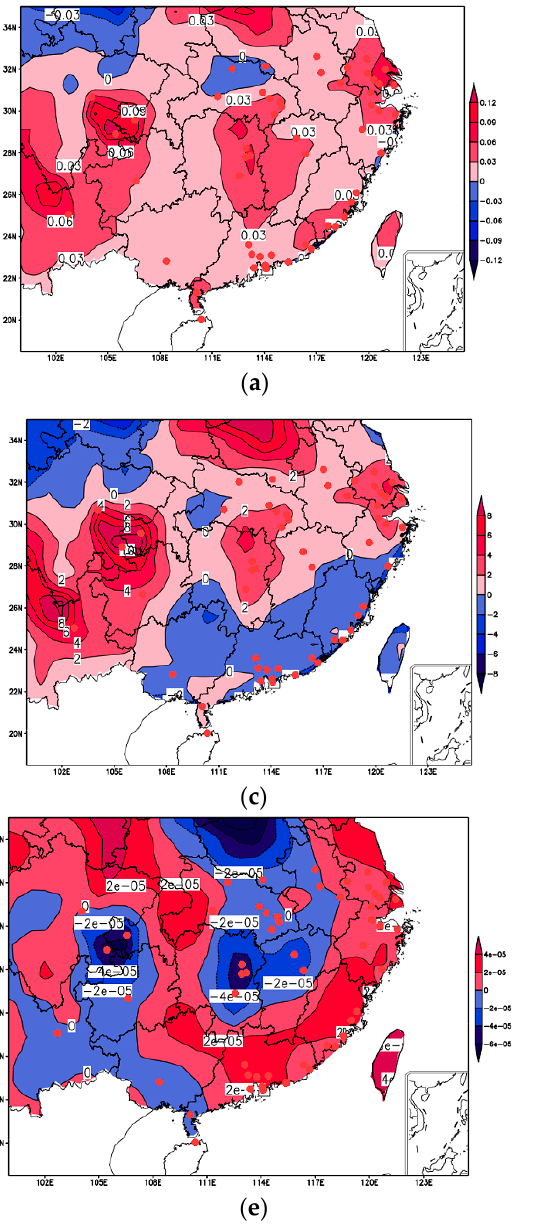
Figure 4. A contour plot of the 17-year (1998-2014), warm-season (May–September) trend of ( a ) skin-temperature(°C·year − 1 ), ( b ) sensible heat flux (W·m − 2 ·year − 1 ), ( c ) boundary layer height (m·year − 1 ), ( d ) evaporation (Kg·m − 2 ·s·year − 1 ), ( e ) 1000 hPa specific humidity (kg·kg − 1 ·year − 1 ) using 0.125° × 0.125° ECMWF data in South China. ( f ) Horizontal wind anomaly at 850 hPa during warm-season (MJJAS) 2006–2014 as the deviation from MJJAS of 1998–2005 (vectors; units: m·s − 1 , AC indicates anticyclonic anomaly).